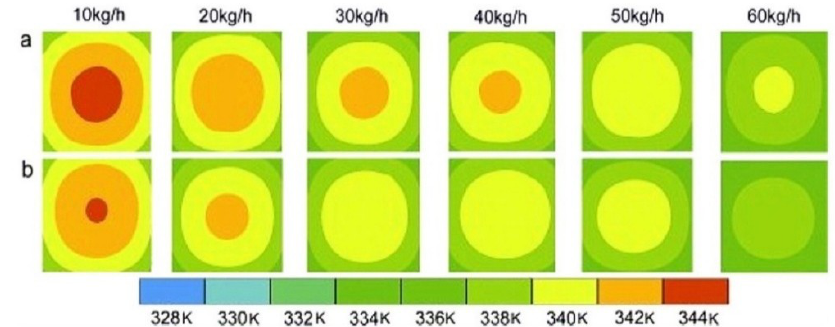
Figure 12. Temperature distribution of concentrator triple-junction PV cell immersed in the 2.5 mm silicon oil thickness with different mass flow rates: ( a , b ) represents the front surface and the rear surface respectively [78].